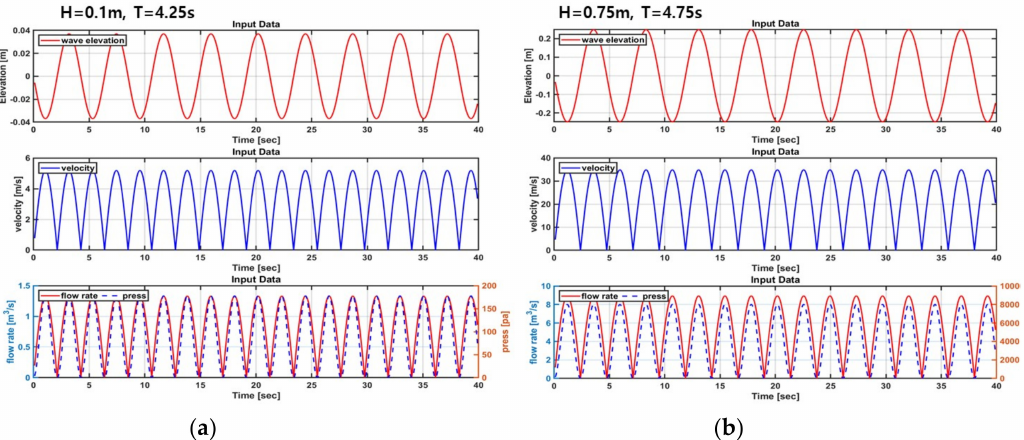
Figure 14. The flow velocity of the turbine( v t ), flow rate, and pressure of the turbine. Under the input regular wave condition ( a ) v t = 0~5 m / s and T = 4.25 s; ( b ) v t = 0~35 m / s and T = 4.75 s.